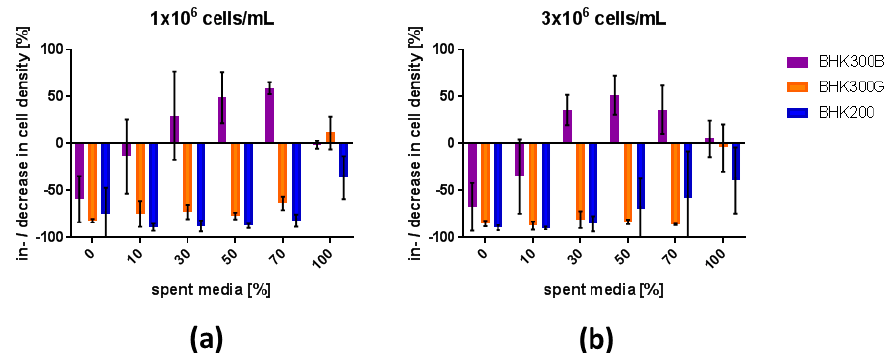
Figure 4. Increase or decrease of the cell density relative to the starting cell density. Increase or decrease in cell density after 20 h of viral infection at a cell density of ( a ) 1 × 10 6 cells/mL or ( b ) 3 × 10 6 cells/mL. Values were calculated from the values recorded in the experiment described above (Figure 3).